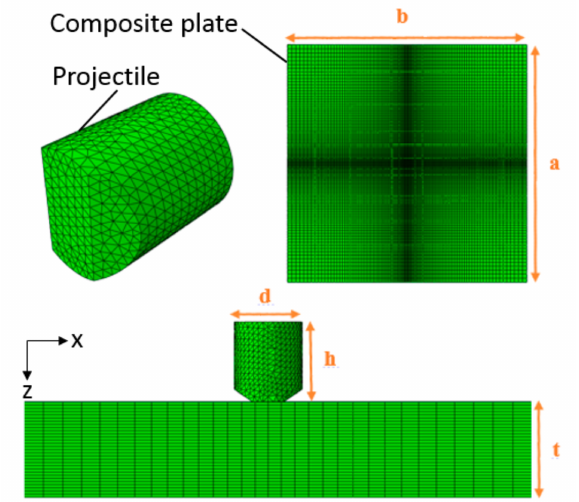
Figure 4. Mesh and dimensions of the composite plate and the